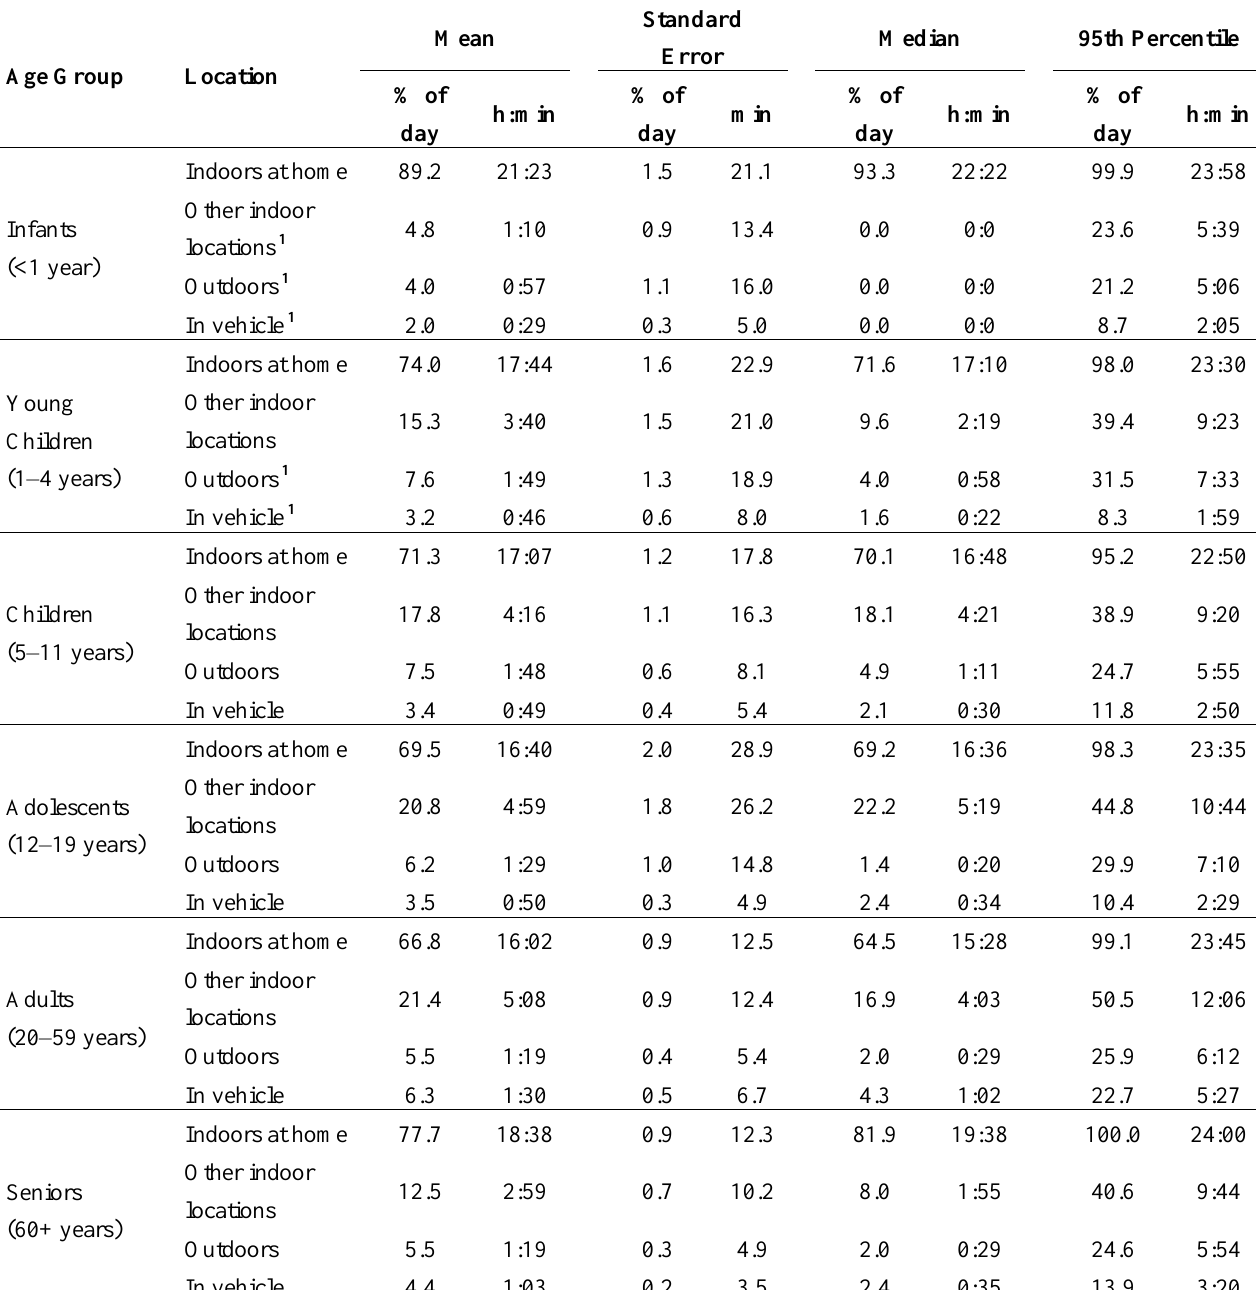
Table 5. Daily time spent in major locations by age